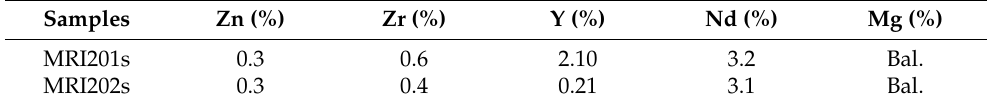
Table 1. The chemical compositions of the experimental Mg alloys (wt%).